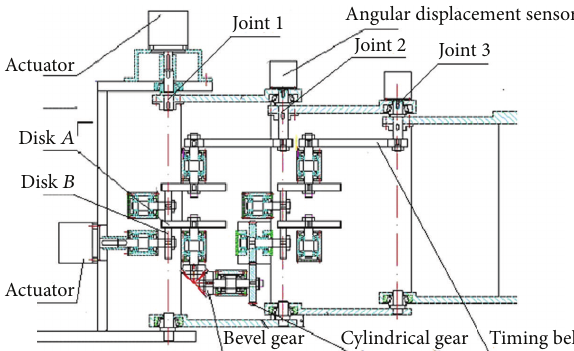
Figure 1: Structural diagram of three-joint underactuated manipu- lator.